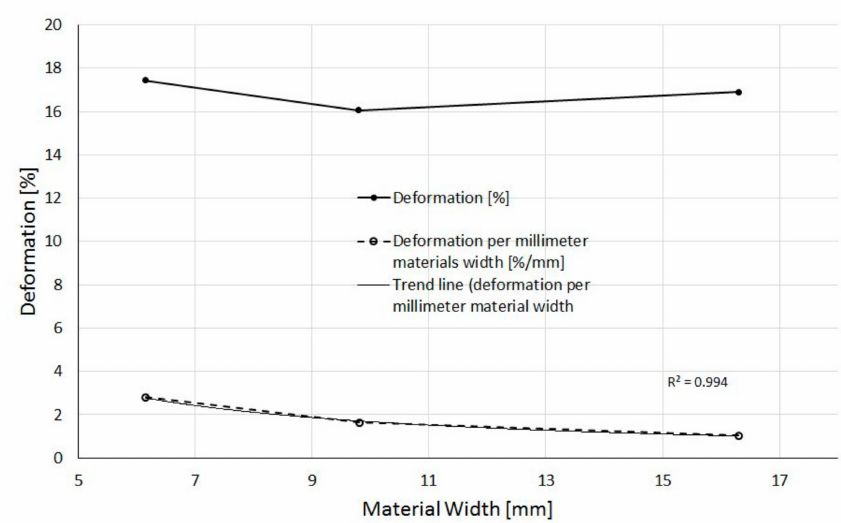
Figure 5. Relation of deformation and related to the material width for Annular 1, 3 and 6, respectively, with an aspect ratio of approximately